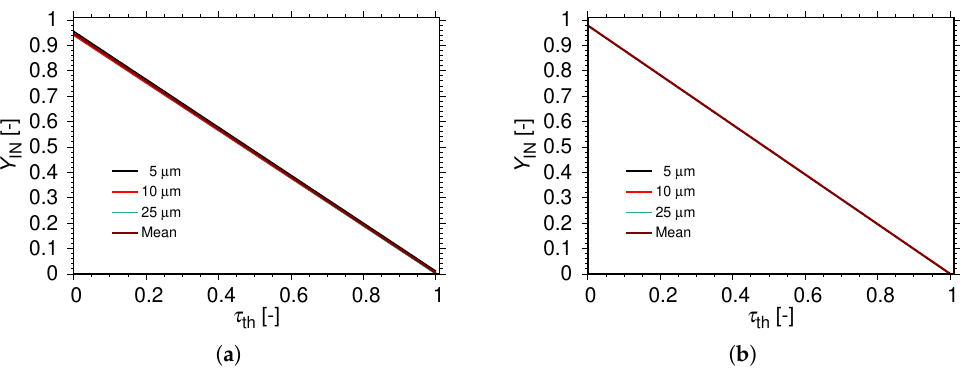
Figure 9. Profiles of the mass fraction of iron(III) nitrate with τ th for different initial droplet sizes. T l,0 = 293.15 K, p = 1 bar, T g,0 = 1200 K, Y C = 0.975, Y INN,0 = 0.025. ( a ) u 0 = 4 m/s. ( b ) u 0 = 8 2 H 5 OH,0